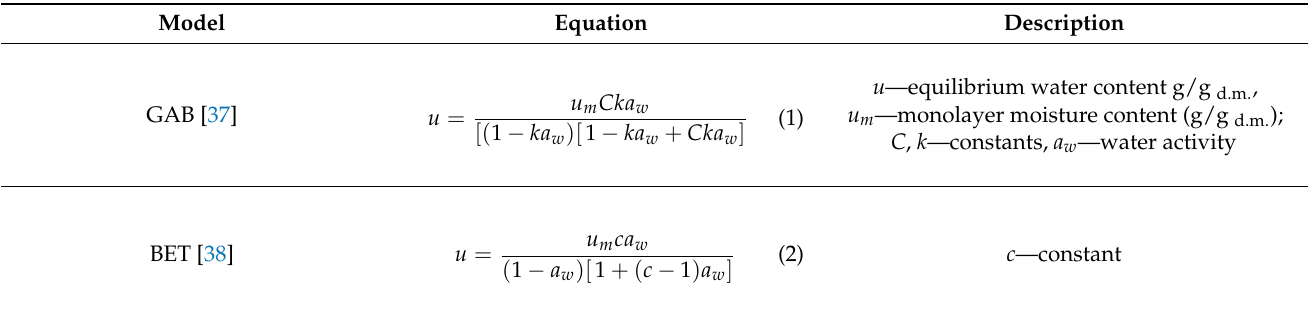
Table 2. List of sorption isotherm